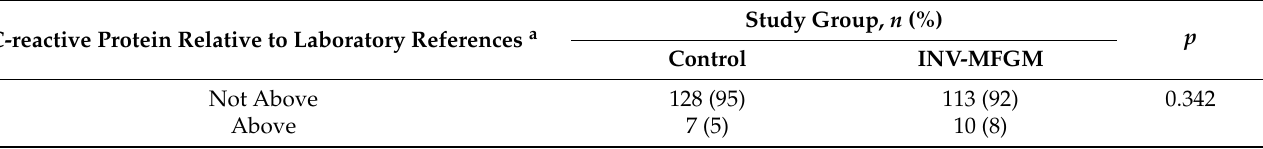
Table 7. C-reactive protein relative to laboratory references at day